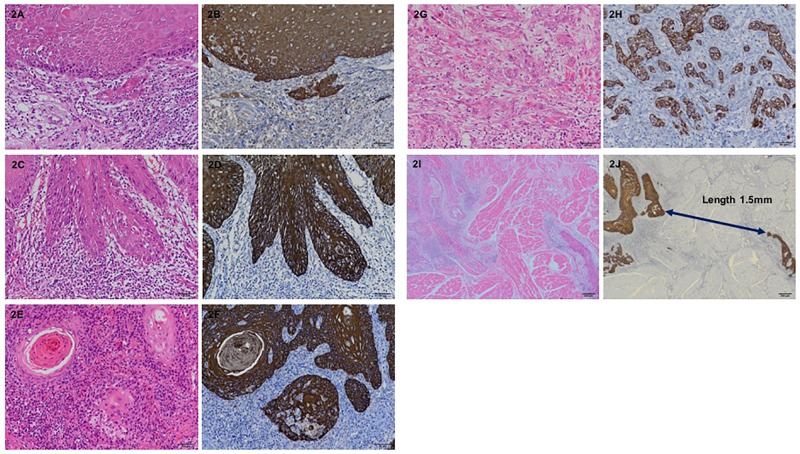
Representative photographs of classification of worst pattern of invasion (H&E staining, immunohistochemical pancytokeratin staining, x200 magnification).(2A,2B) Worst pattern of invasion (WPOI)-1, (2C,2D) WPOI-2, (2E,2F) WPOI-3, (2G,2H) WPOI-4, and (2I,2J, x40 magnification) WPOI-5.